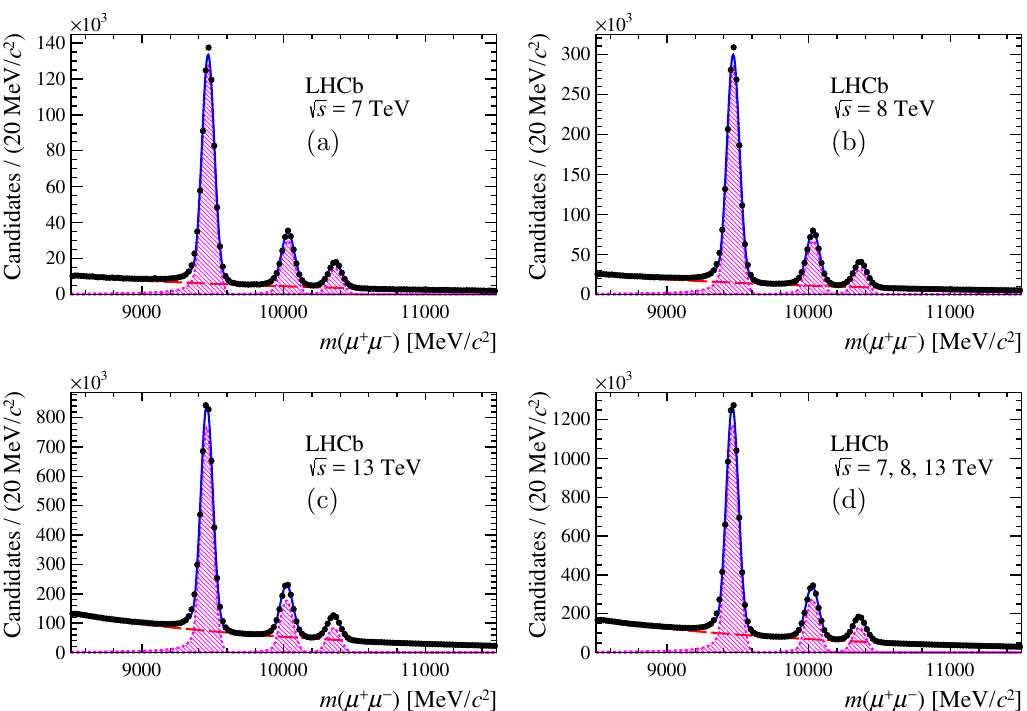
Figure 2 . Distributions of m ( (cid:22) + (cid:22) (cid:0) ) for the normalisation datasets at pp centre-of-mass energies of (a) 7 TeV, (b) 8 TeV, (c) 13 TeV and (d) all combined. The total (cid:12)t function (solid blue line), the combinatorial background (dashed red line) and the (cid:7) (1 S ), (cid:7) (2 S ) and (cid:7) (3 S ) components (hatched magenta area) are shown